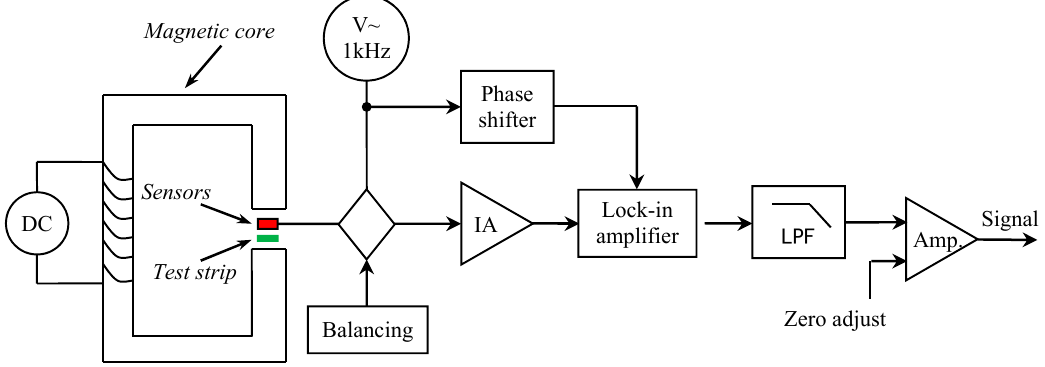
Figure 5. Schematic diagram of LFSs detection system based on differential configuration.